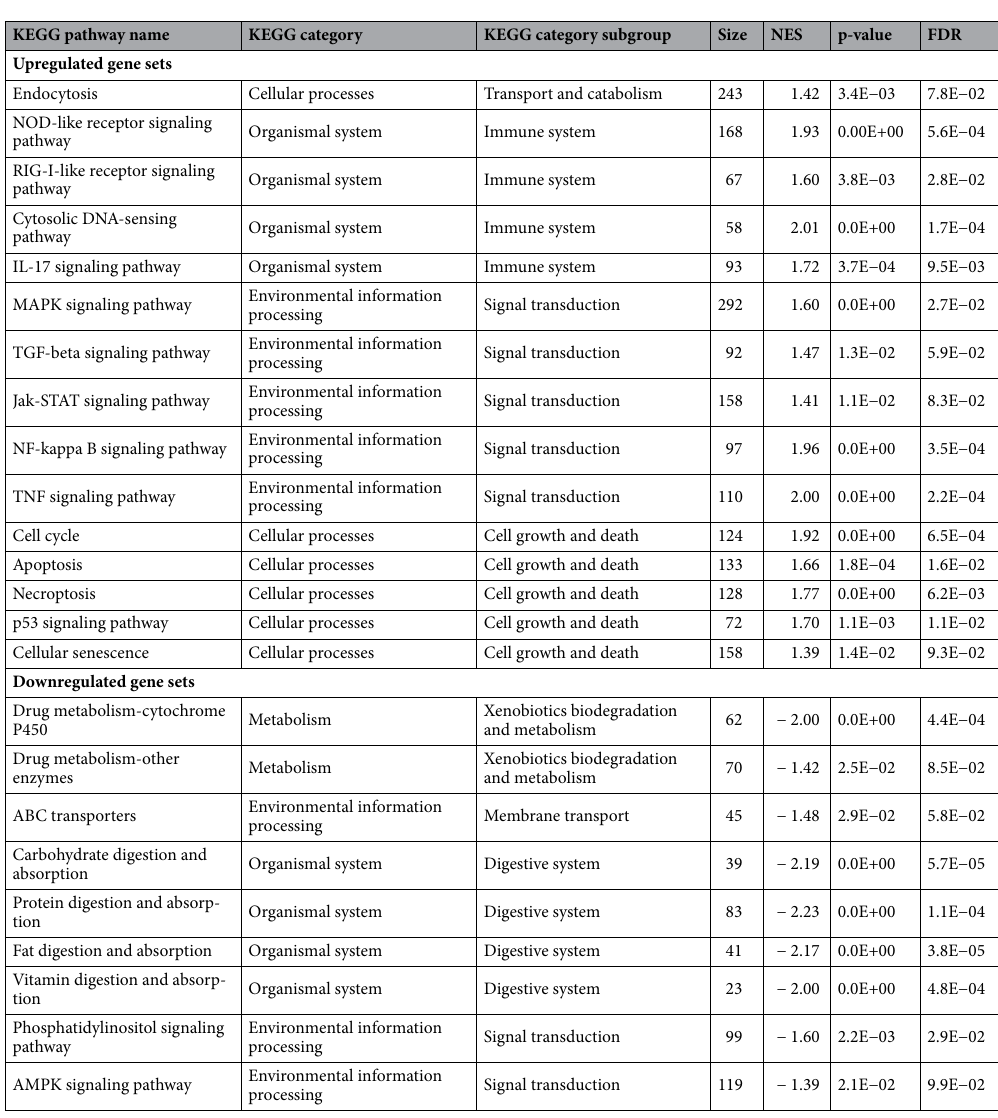
Table 2. Most enriched gene sets representing pathways associated with intestinal cell function, core signaling and cell survival in Caco-2 cells cultured under dynamic conditions compared to static